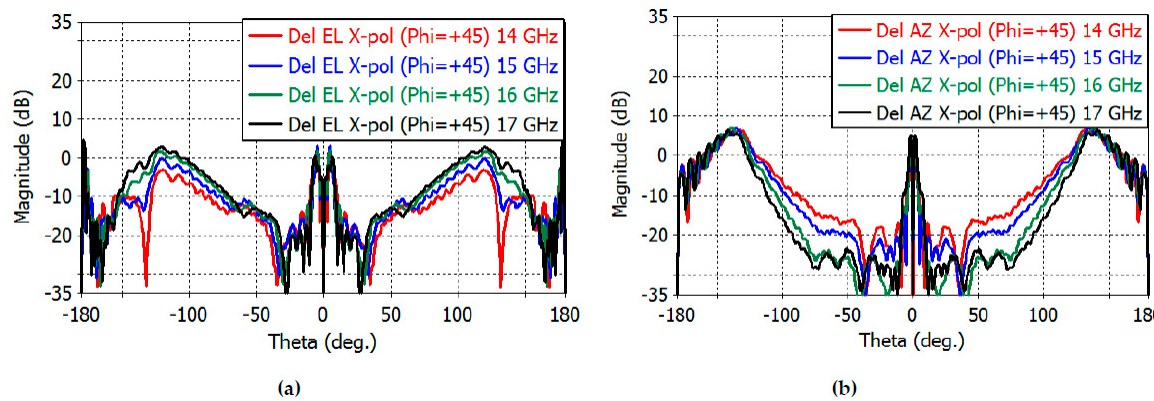
Figure 15. Diagonal-plane cross-polarization directivity of the elevation-difference channel ( a ) and of the azimuth-difference channel ( b ) ( − 180° to 180°).